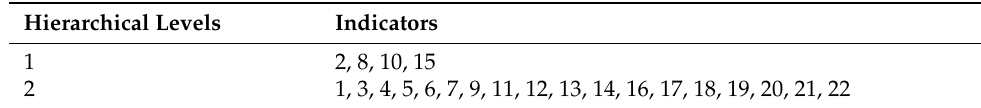
Table 9. Level partition of the assessment indicators. Hierarchical